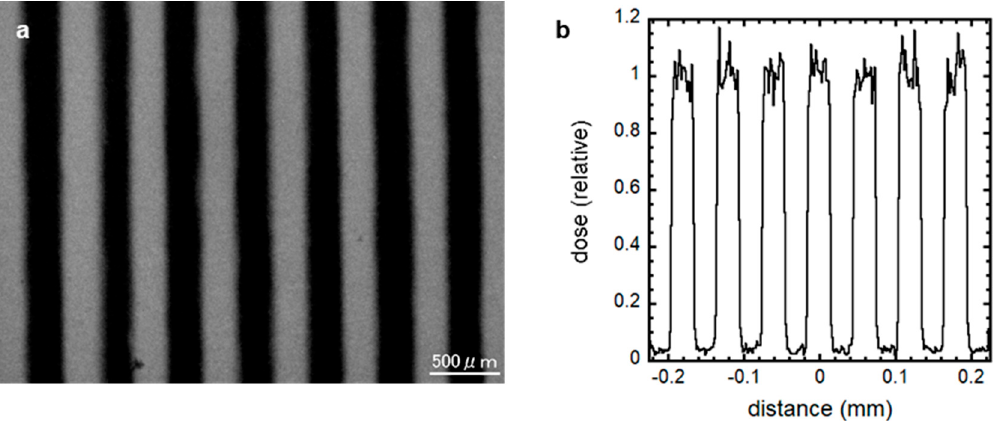
Figure 1. 300 μ m-slit-modulated beam dose profile. The modulated X-ray beams were created by shielding 50% of the cell culture using a 300 μ m-slit Pb shielding material, and the dose distribution was confirmed using a Gafchromic XR-RV3 radiochromic film ( a ) and PHITS code ver. 2.96 ( b ). The irradiated regions in this optical image are shown as a black striped pattern. Scale bar, 500 μ m.